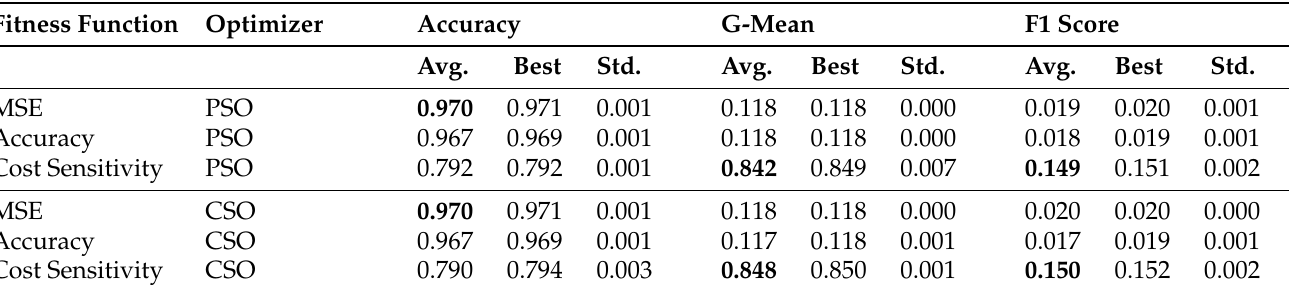
Table 10. The results of the evaluation metrics for all of the fitness functions that were applied to the dataset of Polish companies per optimization algorithm. The best average result for each metric is marked in